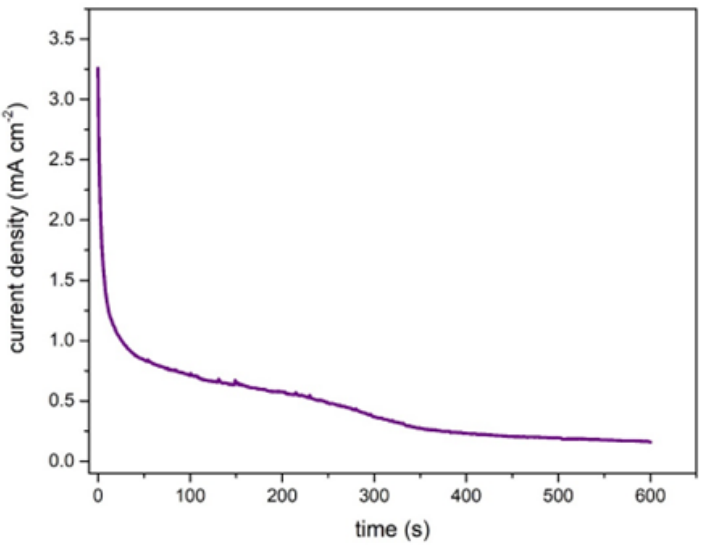
Figure 4. Chronoamperometry of the air-breathing paper-based µFC with TiO 2/ Ni anode and Pt/C cathode inside the qualitative pregnancy test using urine as fuel.